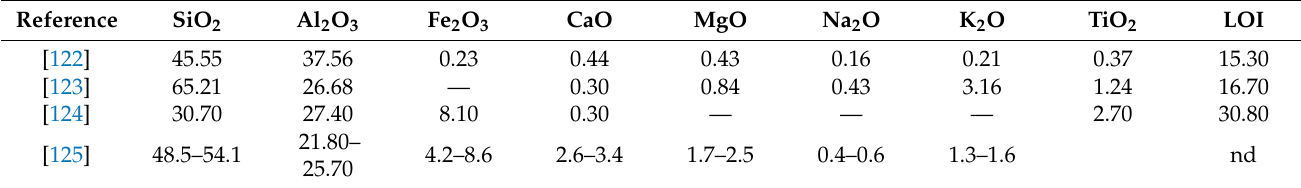
Table 12. Chemical composition (expressed wt.% oxide) of coal gangue.